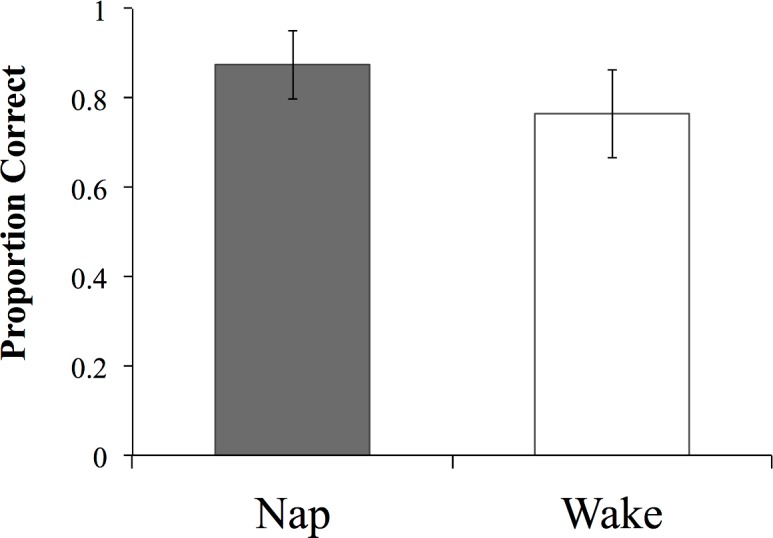
Accuracy (proportion of correct responses) on the determiner selection task in the two groups.Error bars represent 95% CIs.